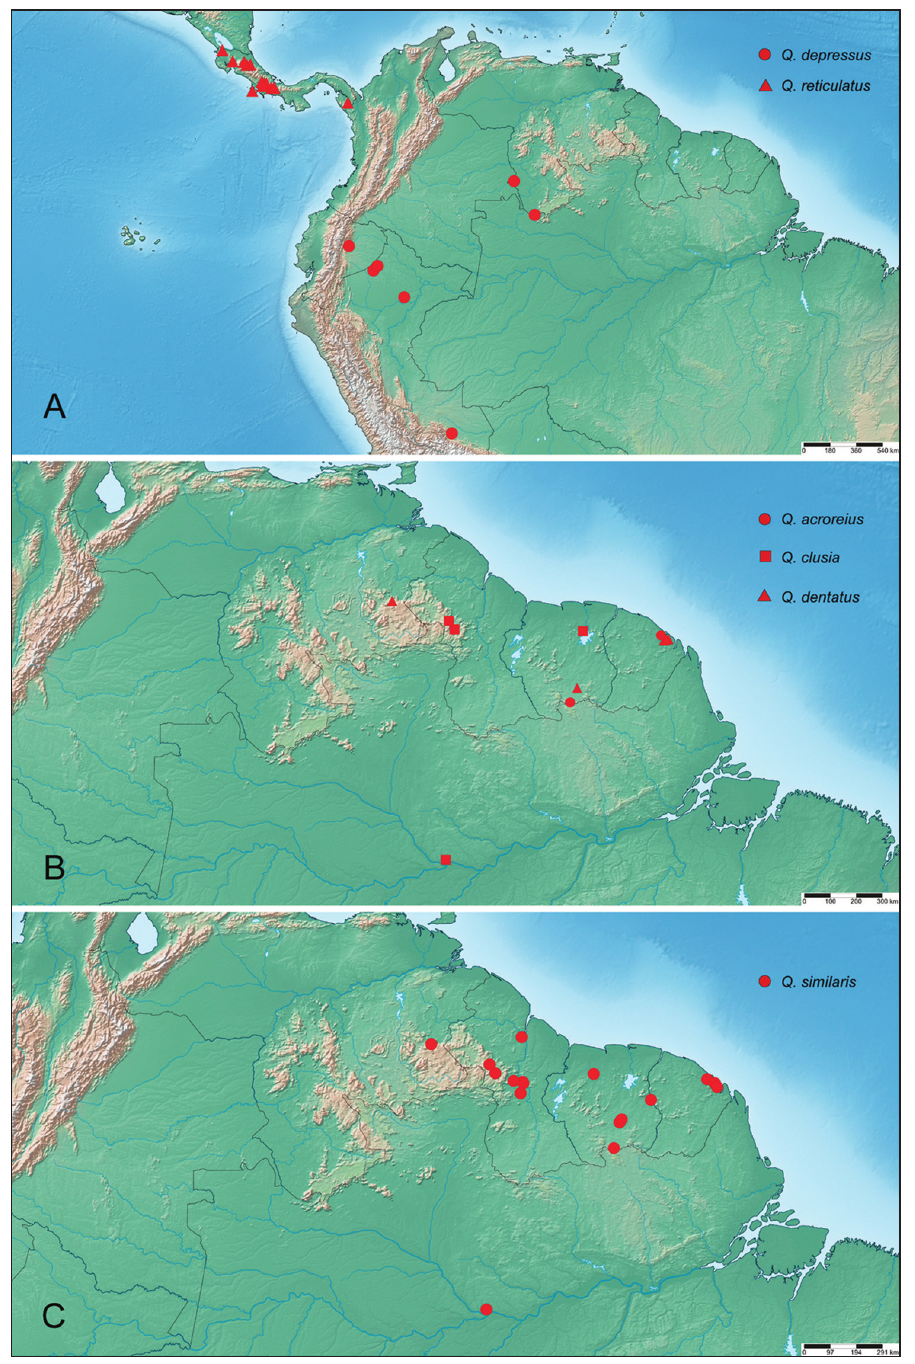
Figure 9. Distribution of Quadriops spp.: A Q. depressus (circles), Q. reticulatus (triangles) B Q. acroreius (circles), Q. clusia (squares), Q. dentatus (triangles) C Q. similaris